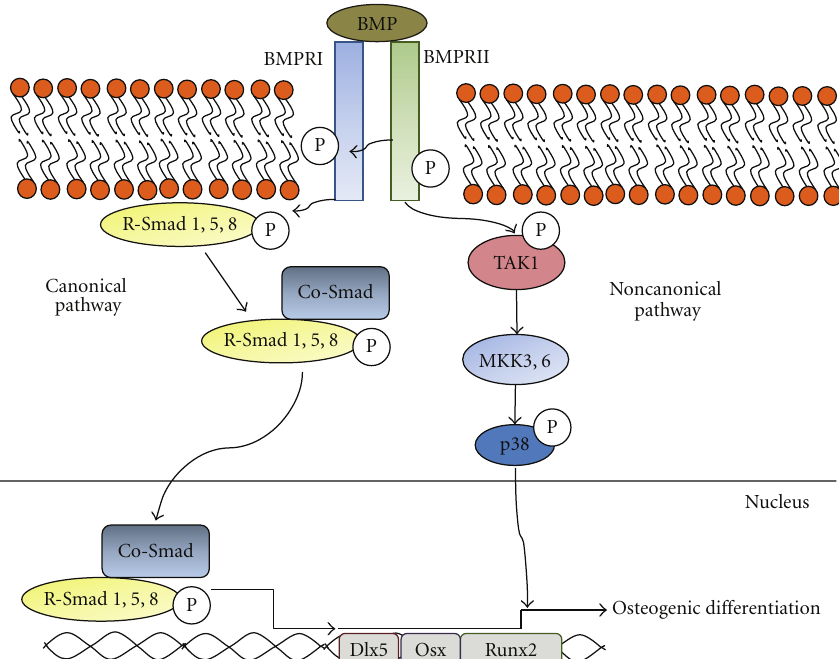
Figure 1: The canonical Smad-mediated and Smad-independent p38 MAPK pathways for BMP signal transduction are shown. In the Smad-mediated pathway, the activation of the BMP receptor complex by BMP ligand interaction leads to phosphorylation of R-Smads 1, 5, and 8, freeing them from the internal surface of the cell membrane. This enables the interaction between R-Smads and Co-Smad proteins, subsequently resulting in exposure of nuclear import sequences that permit the heteromeric complexes to enter the nucleus and activate transcription of osteogenic genes Dlx5, Osterix, and Runx2. In the Smad-independent pathway phosphorylation of TAK1 by the BMP ligand-receptor complex leads to signal transduction through the p38 MAP kinase pathway, resulting in transcription of